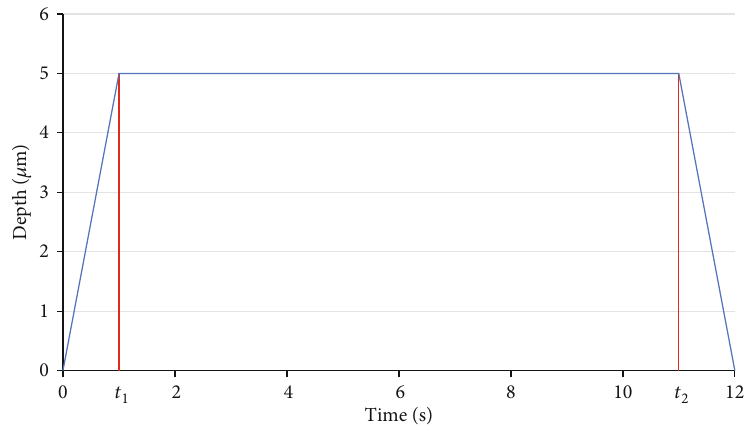
Figure 2: Ramping-holding-unloading procedure.